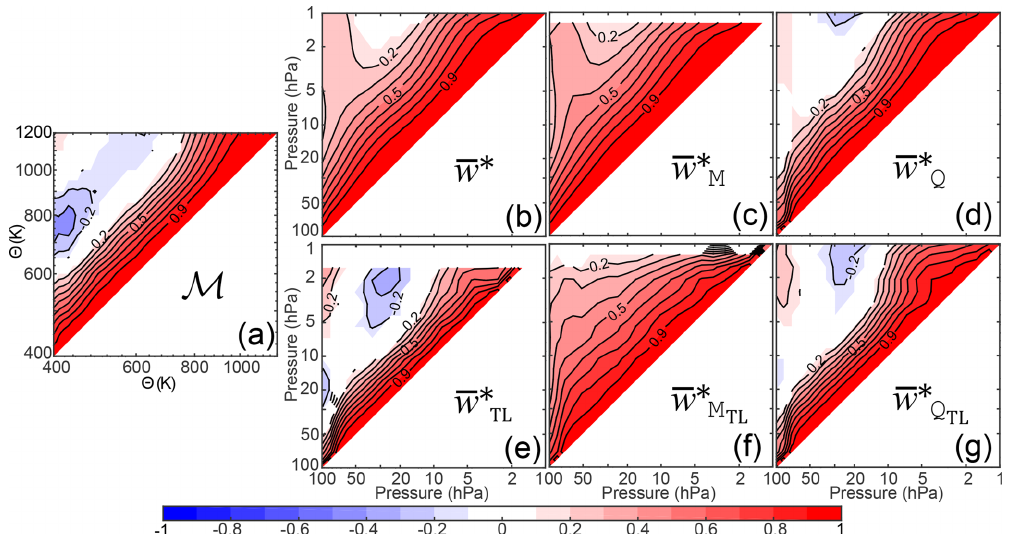
Figure 2. Correlation coefficient ( r ) for the autocorrelation of the deseasonalized time series of (a) the global diabatic circulation and of the three different TEM vertical velocities calculated from WACCM with 30 ◦ tropics: (b) ¯ w ∗ , (c) ¯ w ∗ latitudes (e) ¯ w ∗ , (f) ¯ w ∗ , and (g) ¯ w ∗ . As the diagonal reflection is redundant, it is not shown. Contours are spaced every M Q